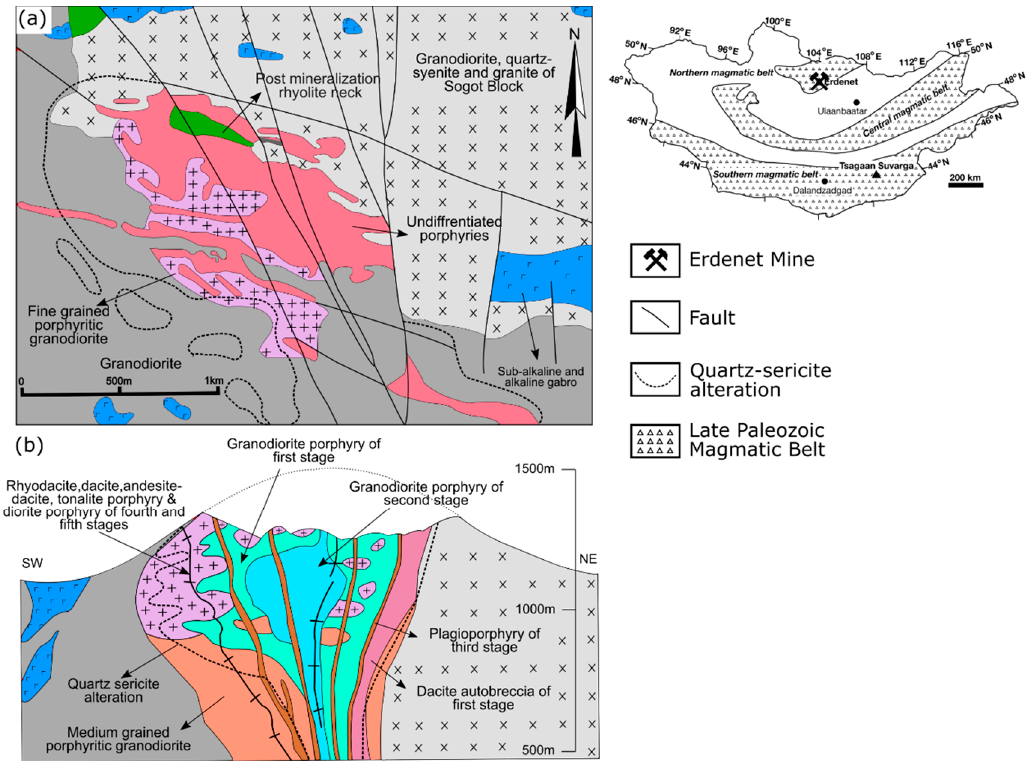
Figure 1 . Geology and structure of the Erdenet deposit, modified after [20]. Insert shows the location of Paleozoic magmatic belts and the study area within the outline of Mongolia. ( a ) Geological map. ( b ) Schematic cross-section through the deposit, showing multiple stages of intrusion.